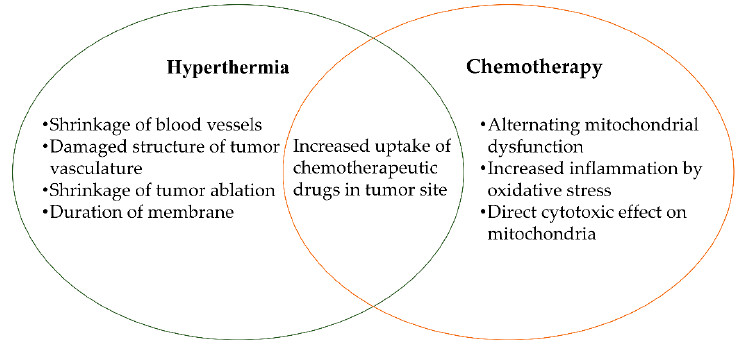
Figure 3. Aspects of combined photothermal chemotherapy cancer treatment.